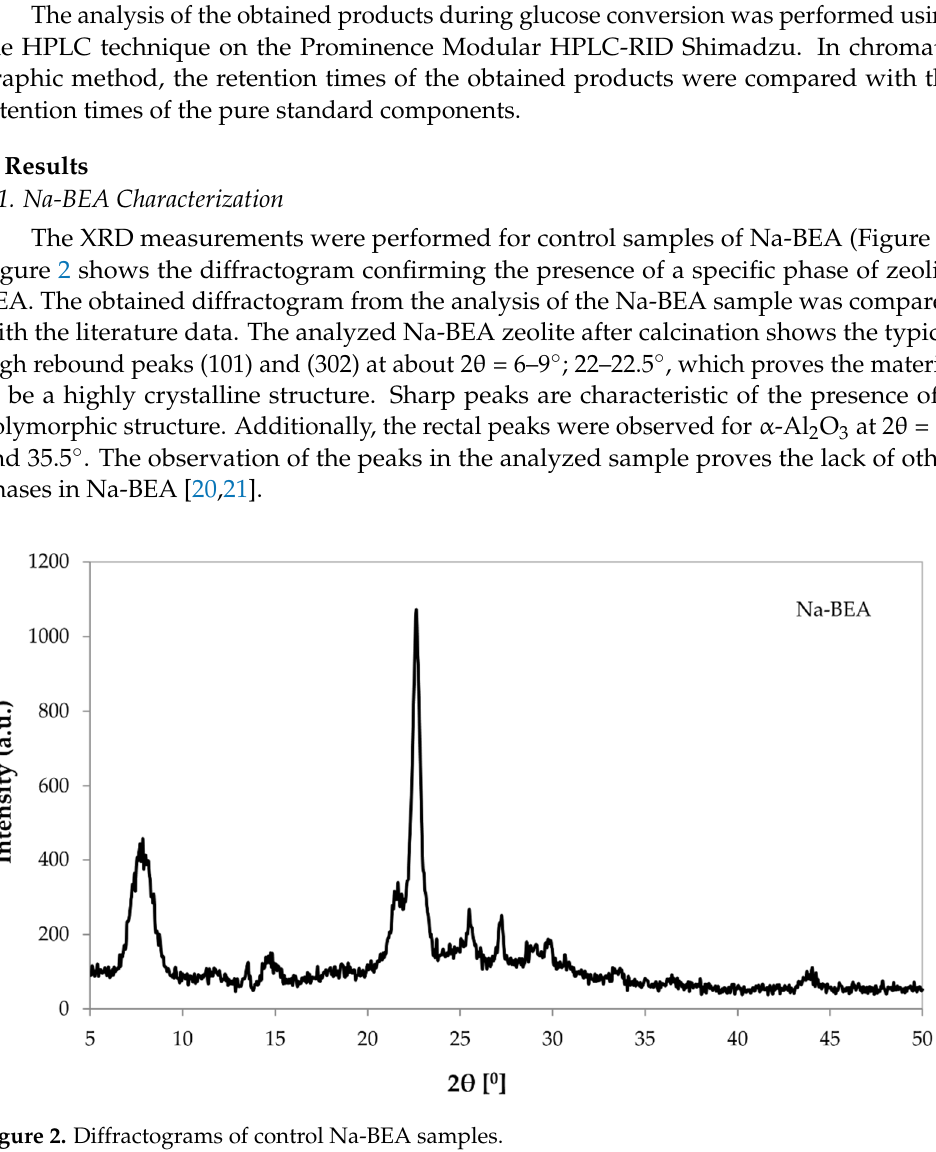
Figure 2. Diffractograms of control Na-BEA samples.